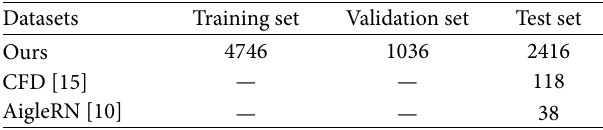
Table 2: The details of datasets.